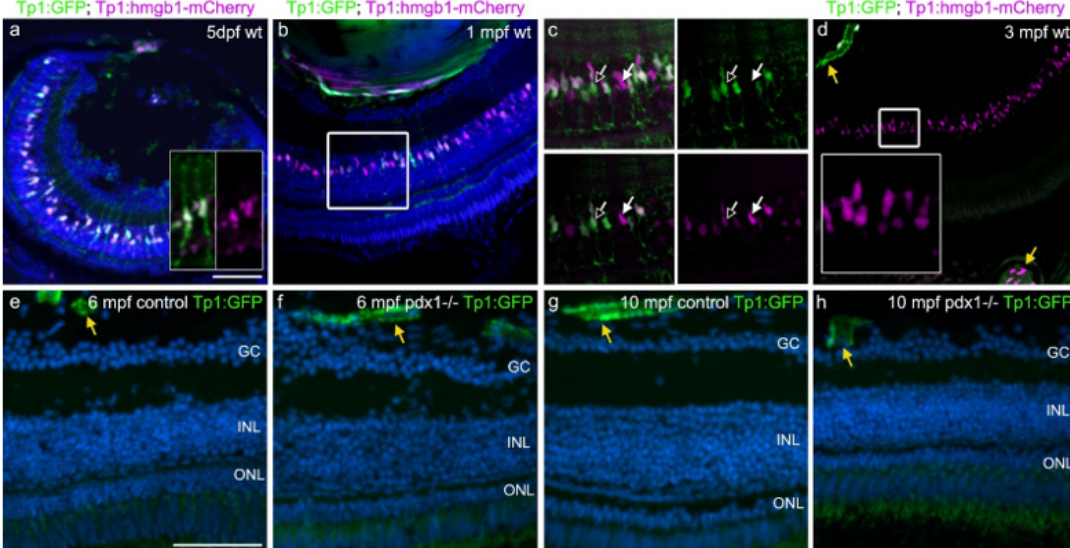
Figure 5. Notch signaling is not re-activated during chronic hyperglycemia. ( a – d ) Tg(tp1:GFP;tp1:hmgb1-mCherry) double transgenic 5 dpf larvae ( a ) and adults ( b – d ) showed gradual loss of GFP expression in the INL over time, while hmgb1-mCherry expression labeled cells in the INL through adulthood. In some GFP-positive cells at 5 dpf, projections extend along the apical–basal axis ( a , inset). In ( c ), which shows a close-up of the boxed region in ( b ), GFP and mCherry variably overlap in INL nuclei. At 3 mpf, INL cells show variable levels of mCherry, and are GFP negative ( d , inset). GFP and mCherry are coexpressed in retinal and choroidal vessels ( d , yellow arrows). ( e – h ) In 6 mpf ( e , f ) and 10 mpf ( g , h ) control and pdx1 − / − mutants, GFP expression via notch-responsive elements cannot be detected in the neural retina. Expression is limited to retinal and choroidal vessels (yellow arrows). Sections were counterstained with DAPI (blue). Scale bar: 50 μ m. (GC, ganglion cell layer; INL, inner nuclear layer; ONL, outer nuclear layer).